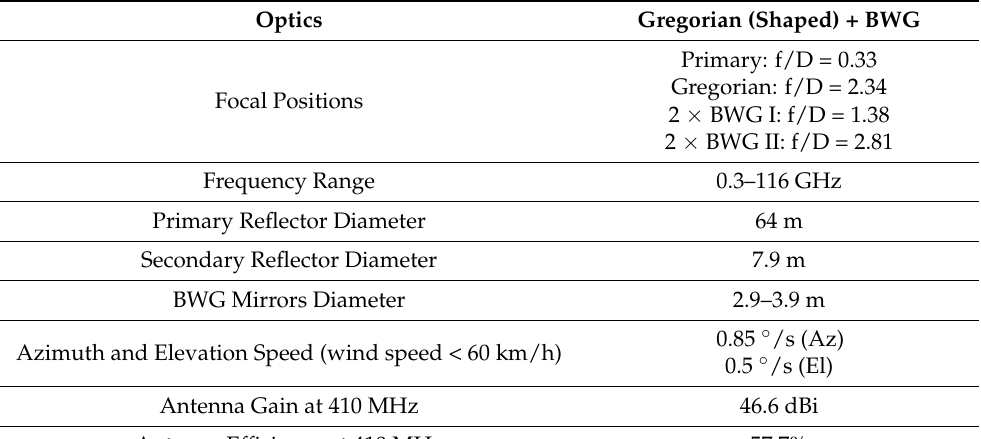
Table 1. Key features of the Sardinia Radio Telescope (SRT). BWG, beam waveguide system.